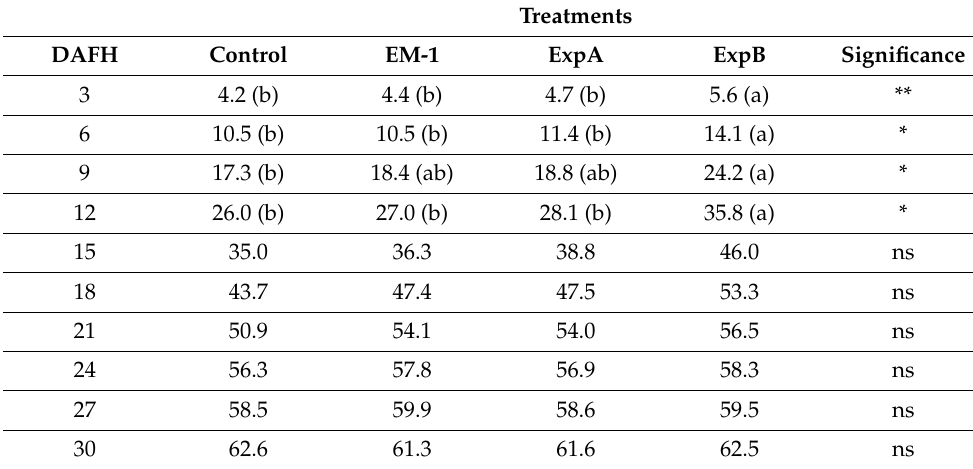
Table 4. Evapotranspiration (g) of creeping bentgrass from 3 to 30 days after full hydration (DAFH) for grass mats treated with the untreated control, EM-1, ExpA and ExpB.